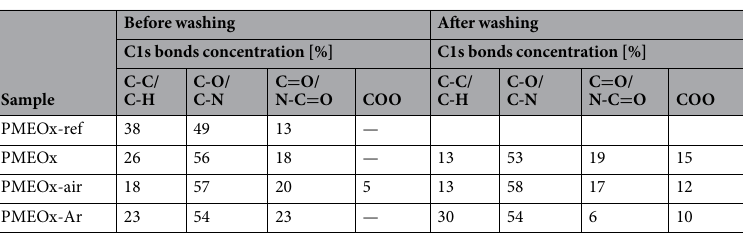
Table 1. The relative percentage of chemical bonds observed from high-resolution C1s spectra of PMEOx samples before and after washing. PMEOx reference layer is compared to samples without plasma post- treatment (PMEOx), treated by air-plasma (PMEOx-air) and argon-plasma (PMEOx-Ar). The values of concentrations of chemical bonds after washing are recalculated with exclusion of CF x